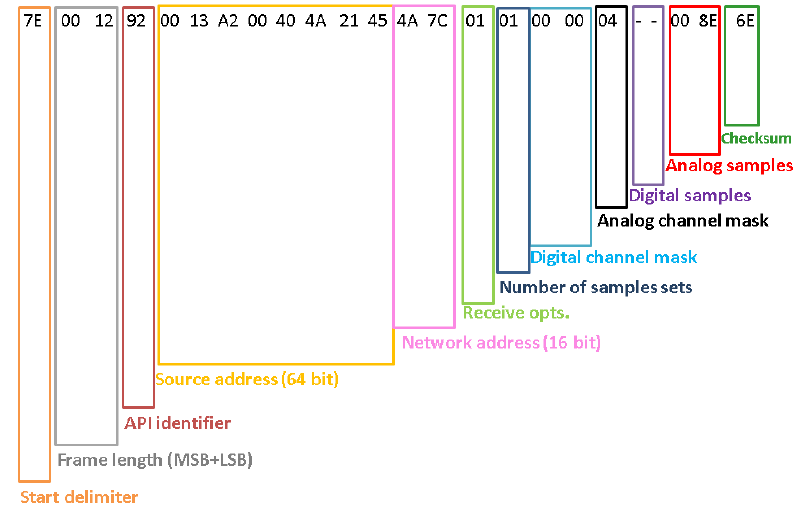
Figure 7. Structure of the automatic sampling data packet transmitted by the node. The sensed value is the Analog Sample which is expressed in hexadecimal